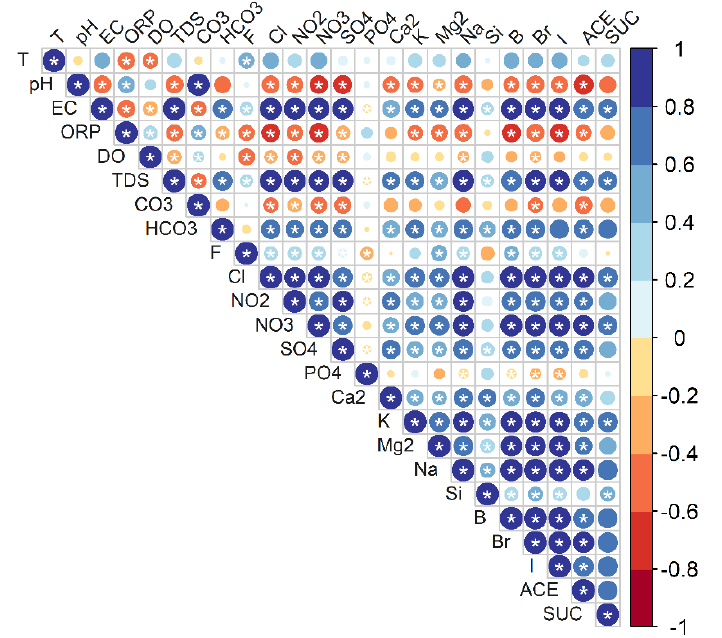
Figure 6. Spearman correlation plot for groundwater parameters in the MMA. * Correlation is significant at the 0.05 level (two tailed).